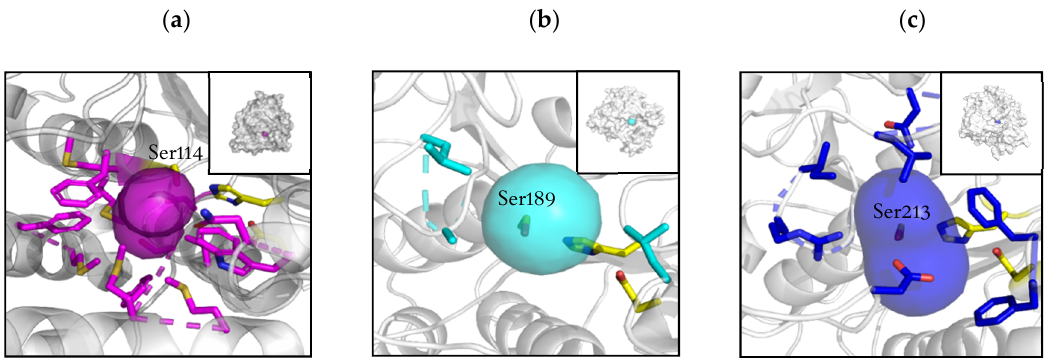
Figure 2. Graphic representation of the tunnel leading to the active site. The catalytic triad is showed in yellow and the residues participating in the tunnel in pink for BCE ( a ), light blue for BS2m ( b ) and dark blue for HeE ( c ). The catalytic serine is labelled in all structures.